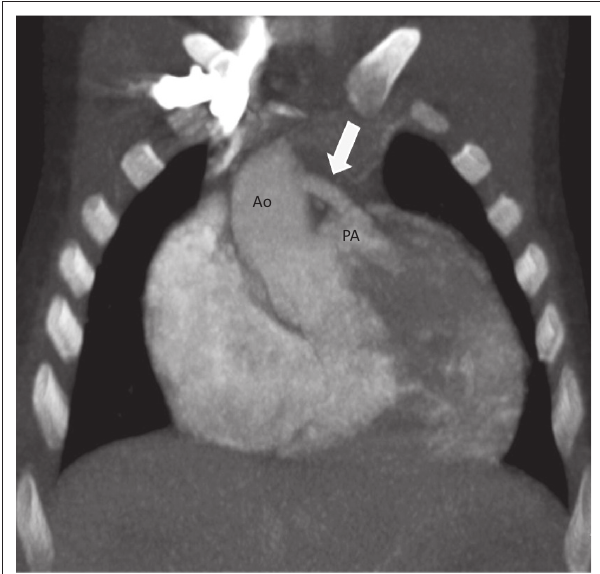
FIGURE 12: Palliative central shunt in a 6-year-old boy with TOF. Thick-section coronal MIP image demonstrates PTFE graft (arrow) between the ascending aorta and the pulmonary artery.